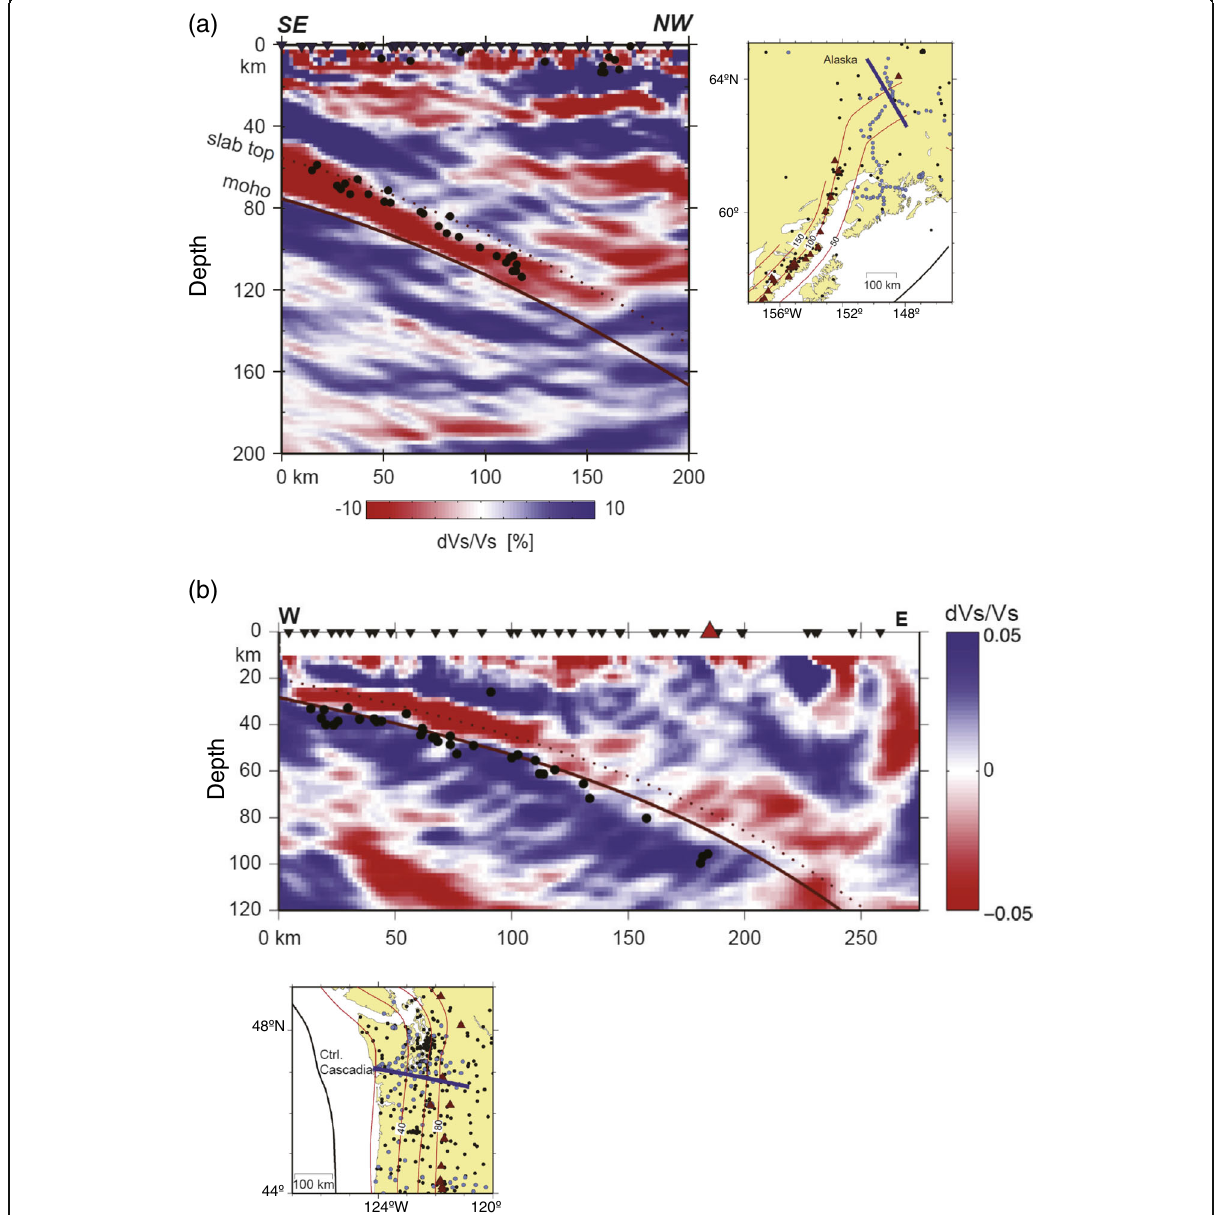
Fig. 16 S-wave velocity structures in central Alaska and central Cascadia. Across-arc seismic sections are shown along lines in the inset maps under a central Alaska and b central Cascadia (Abers et al. 2013, originally from Rondenay et al. 2008, 2010 and Abers et al. 2009). Colored images show migrated teleseismic P coda as dVs/Vs (S-wave velocity perturbation). dVs/Vs values are shown by the color scale at the bottom ; red and blue correspond to slow and fast velocities, respectively. Black circles denote earthquakes. Dotted and solid lines indicate the upper slab surface and the slab Moho, respectively. Inverted black triangles show seismic stations used, and the red triangle in b shows a